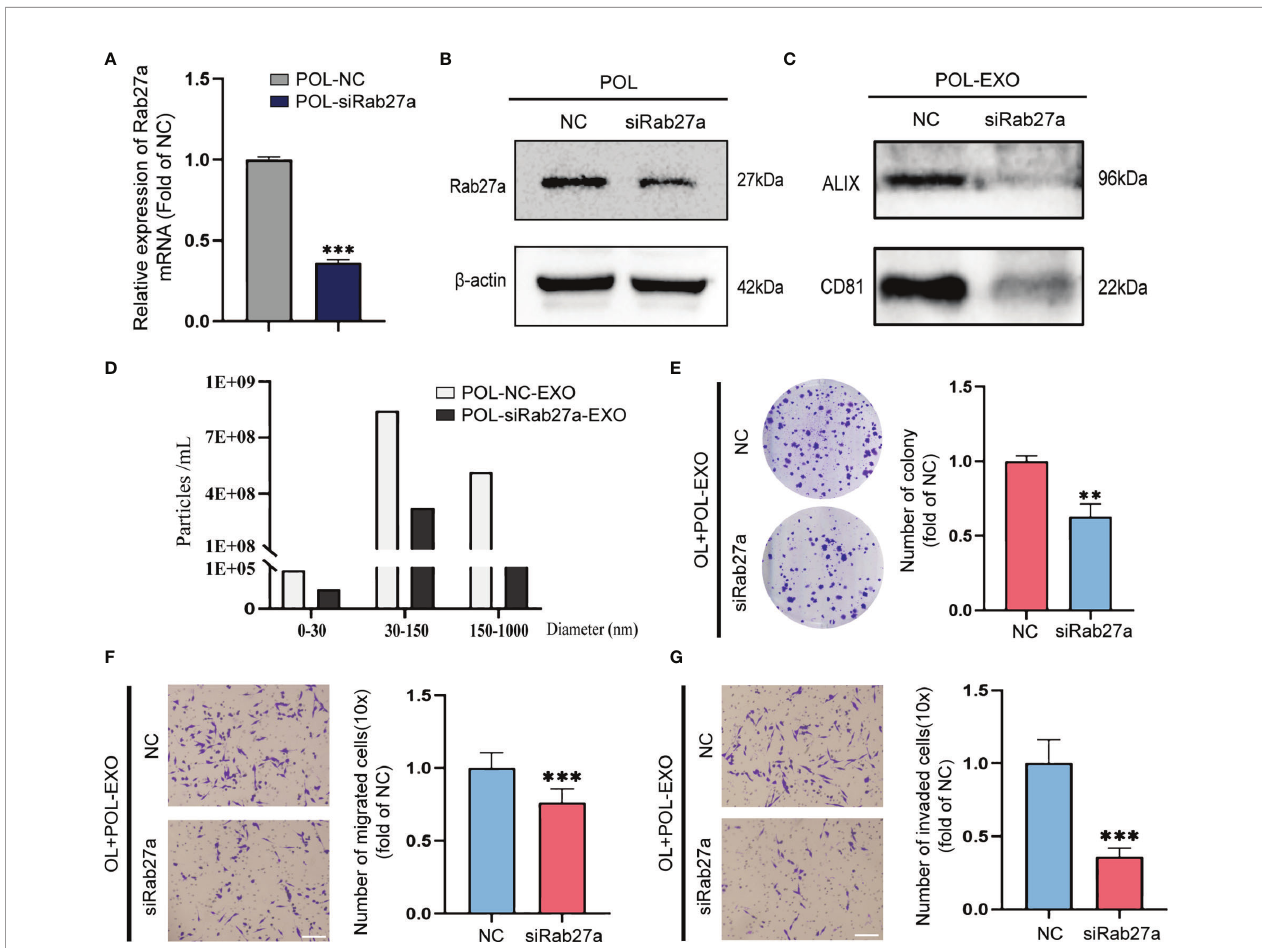
FIGURE 2 | Rab27a knockdown reversed the effect of POL-EXO on the metastasis of OL cells in vitro . qPCR measurement of mRNA expression of Rab27a in POL- NC and POL-siRab27a (A) , ***p < 0.001). (B) WB analysis to con fi rm effective Rab27a knockdown. (C) WB analysis of exosome markers ALIX and CD81 expression in POL-NC-EXO and POL-siRab27a-EXO. (D) The concentration of exosomes secreted by POL-NC and POL-siRab27a cells. The effect of exosomes secreted by POL-NC and POL-siRab27a cells on the proliferation of OL cells was measured using colony formation assays (E) , **p < 0.01). Transwell assays without Matrigel or with Matrigel were used to determine the effect of exosomes secreted by POL-NC and POL-siRab27a cells on the migration (F) , bar = 60 m m, ***p < 0.001) and invasion (G) , bar = 60 m m, ***p < 0.001) of OL cells,